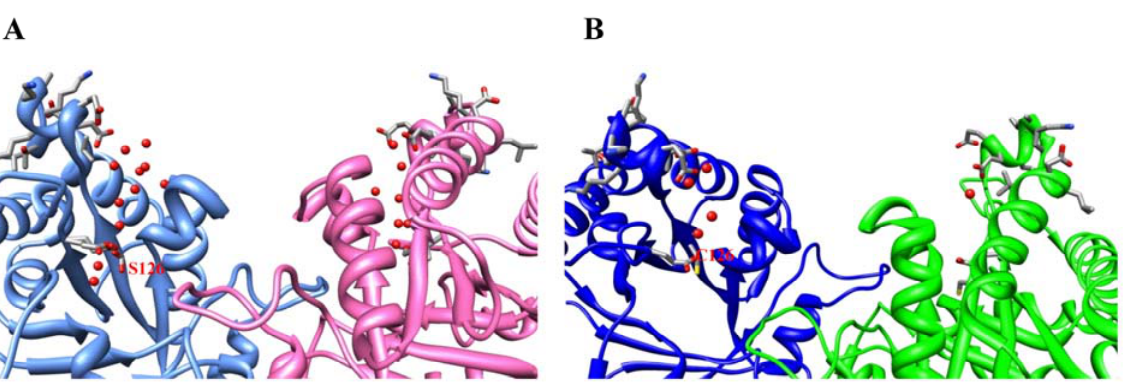
Figure 3. Waters surrounding residue 126 in ScTIM and PfTIM. ( A ) ScTIM C126S mutant; ( B ) wild-type ScTIM (PDB code 1YPI; ( C ) PfTIM C126S mutant (PDB code 3PVF and ( D ) wild-type PfTIM (PDB code 2VFI). It is also shown the side chains